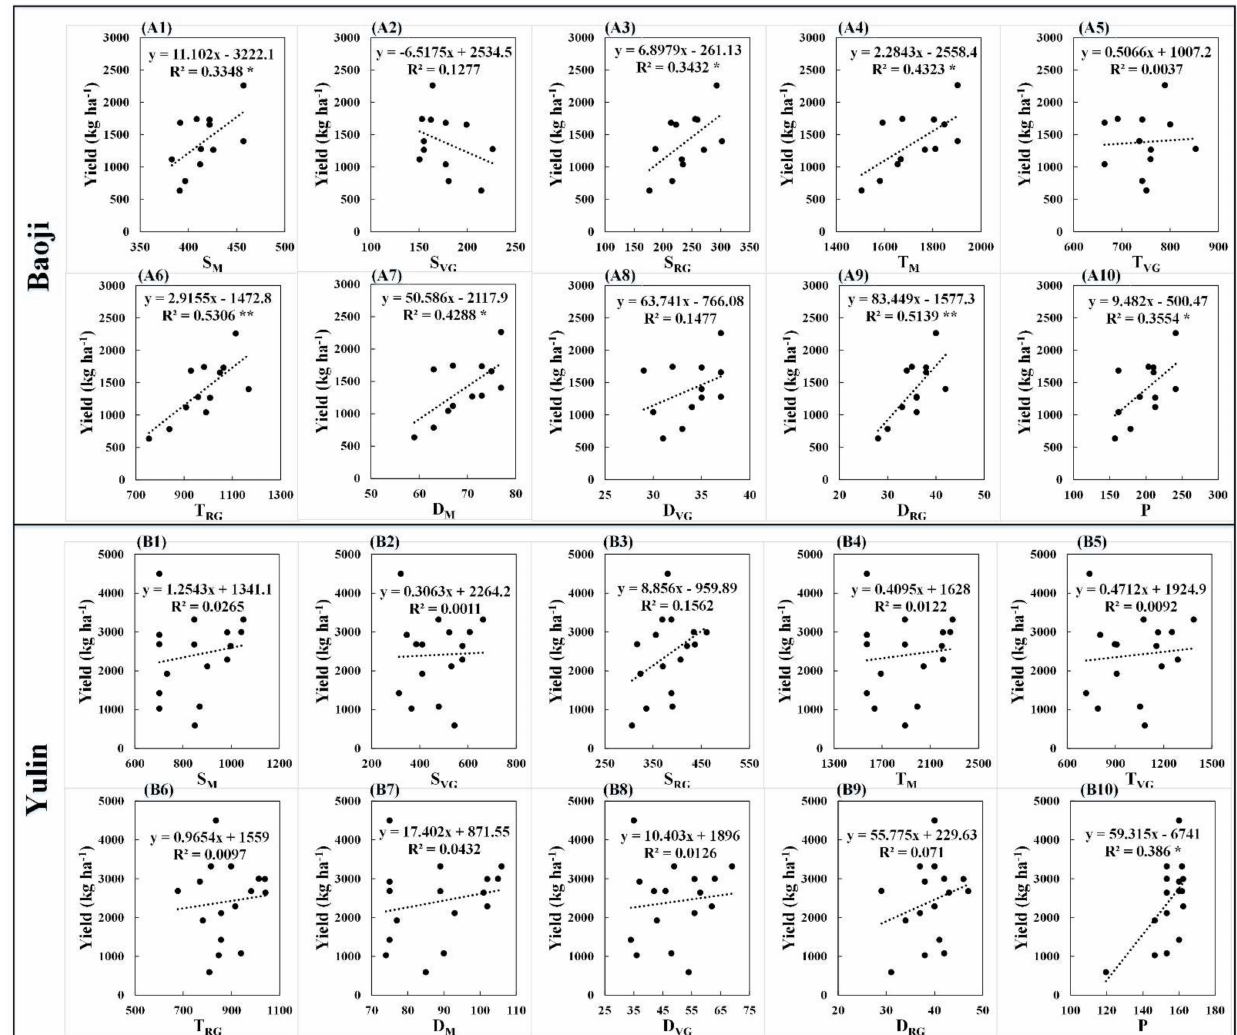
Figure 6. The linear fitting relationship between yield and sunshine duration ( A1 – A3 and B1 – B3 ), accumulated temperature ( A4 – A6 and B4 – B6 ), the number of growth days ( A7 – A9 and B7 – B9 ) and precipitation ( A10 and B10 ) during the growing period in Baoji ( A ) and Yulin ( B